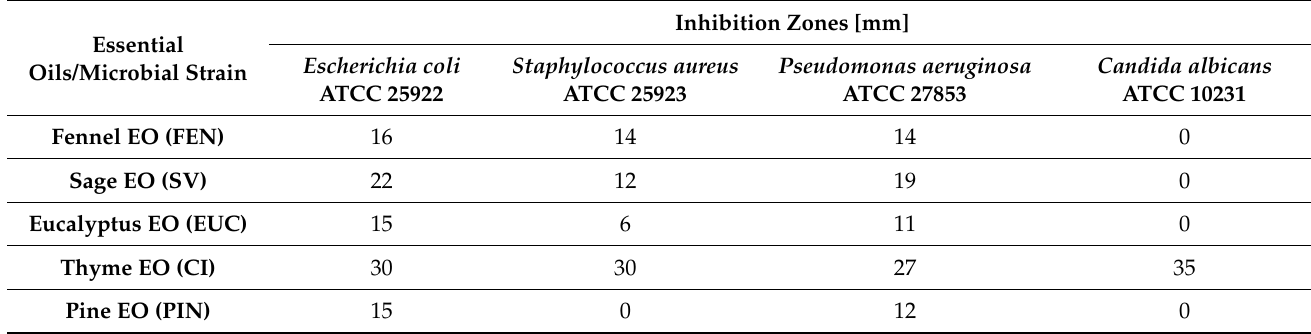
Table 5. Inhibition zones of essential oils (dil. 1/10 in DMSO).